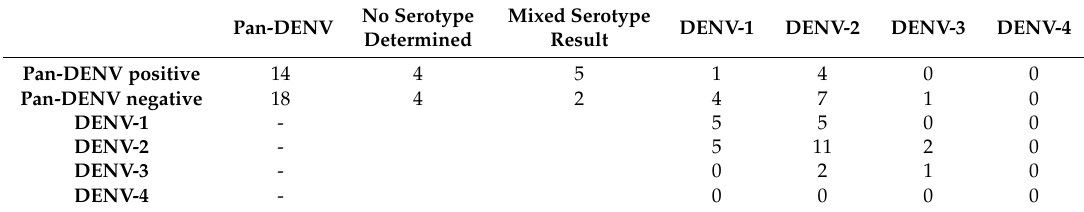
Table 8. Summary of results from pan-DENV and serotype-specific DENV RT-PCR. Number of patient samples in each group are